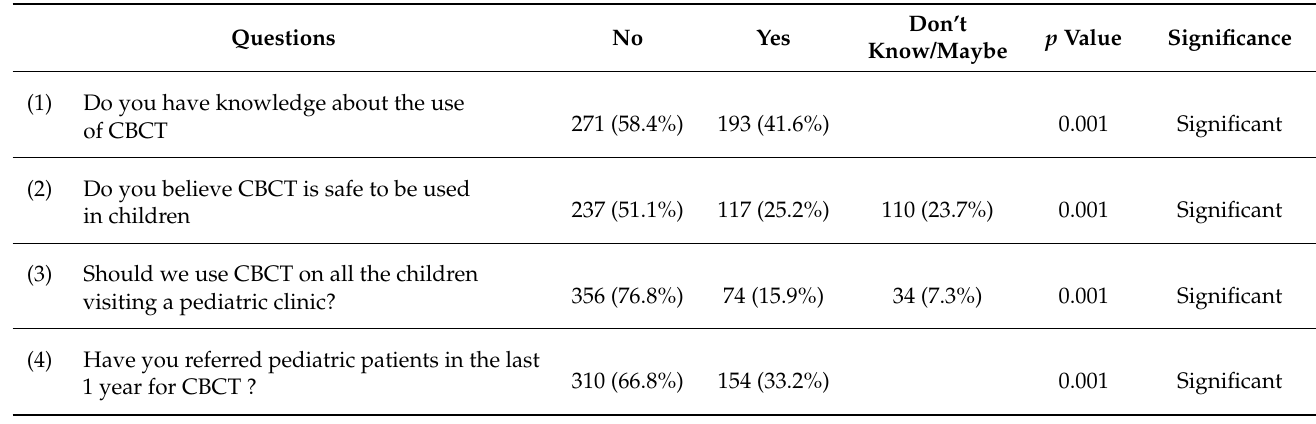
Table 1. Knowledge regarding